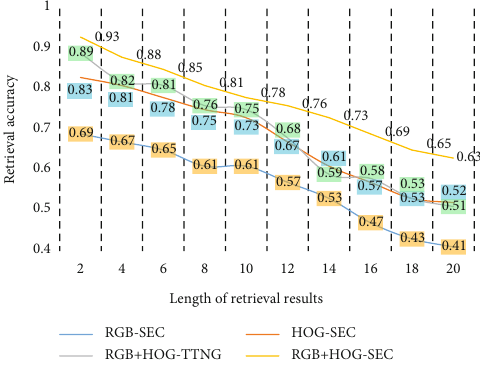
Figure 7: Retrieval results of TTNG and SEC in three kinds of data.